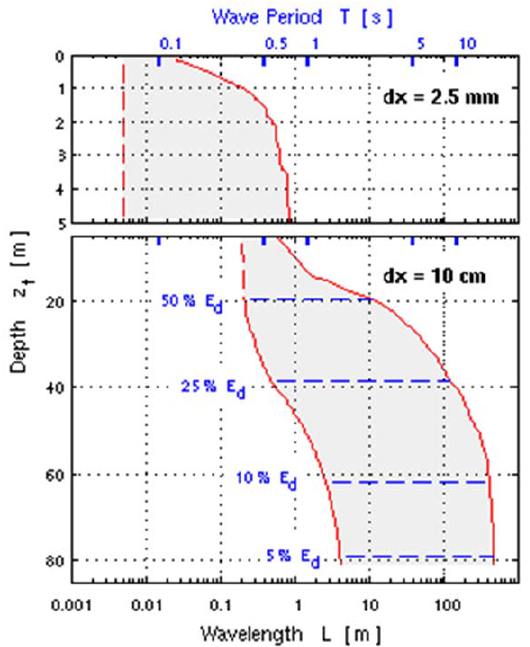
; (c) : mean fluctuation length L max